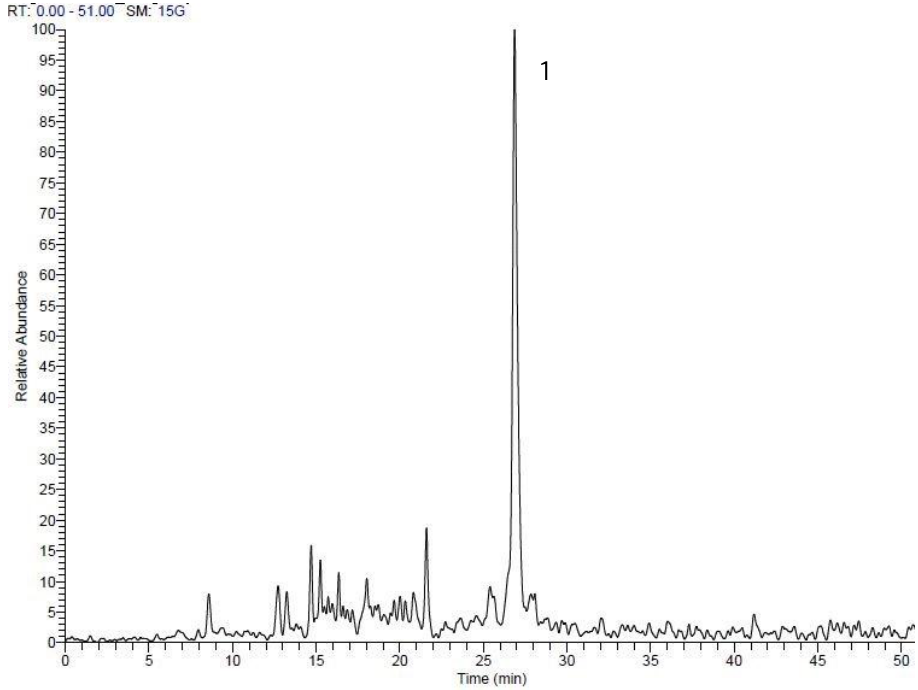
Figure 4. Reconstructed ion chromatogram (RIC) obtained from LC-MS in the positive ionization mode ESI (+) of the Allium cepa extract. Peak number corresponds to the compound in Table 2. Table 1. Identification of sulfur-containing compounds in Allium sativum extract by LC-ESI-MS/MS.